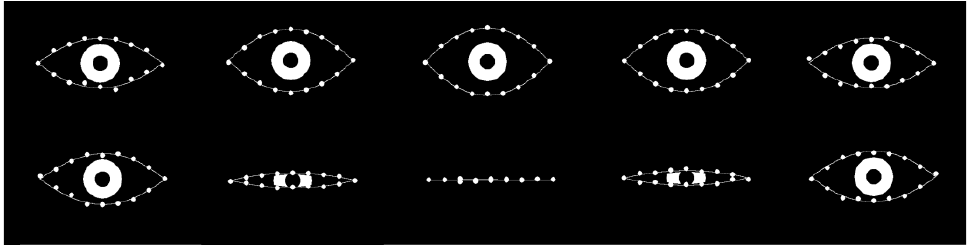
Figure 6. Results of standardized component scores for the test set of 10,000 different trajectories per group in the test set for the Blink dataset: ( left ) single-level PCA; ( right ) level 1, mPCA. These results again show strong clustering with respect to the two groups (i.e., “surprised” in group 1 and “blinking” in group 2.).